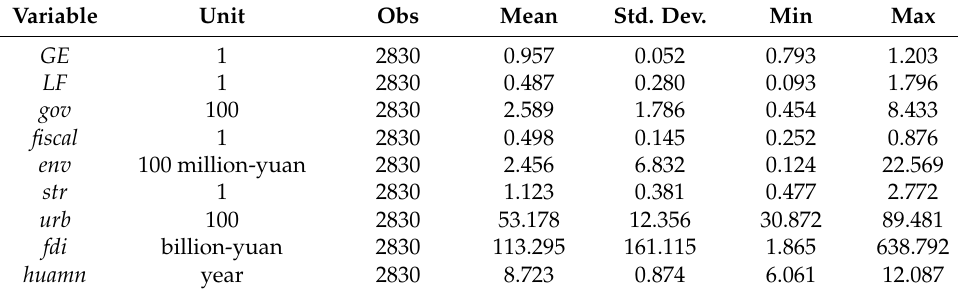
Table 2. Descriptive statistics of